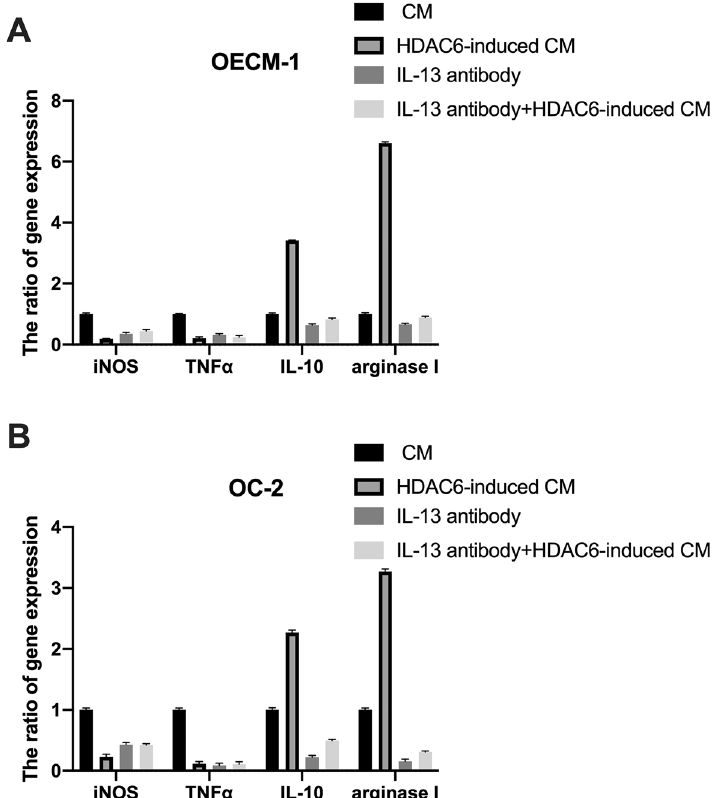
Figure 4. HDAC6-induced CM promoted M1 polarization of macrophages. CM, HDAC6-induced CM, IL-13 antibody and IL-13 antibody + HDAC6-induced CM from OEC-M1 ( A ) or OC-2 ( B ) cells was used to treat THP-1 cells. After 24 h, THP-1 cell mRNA was extracted, and iNOS, TNFα, IL-10 and arginase I gene expression was analyzed by